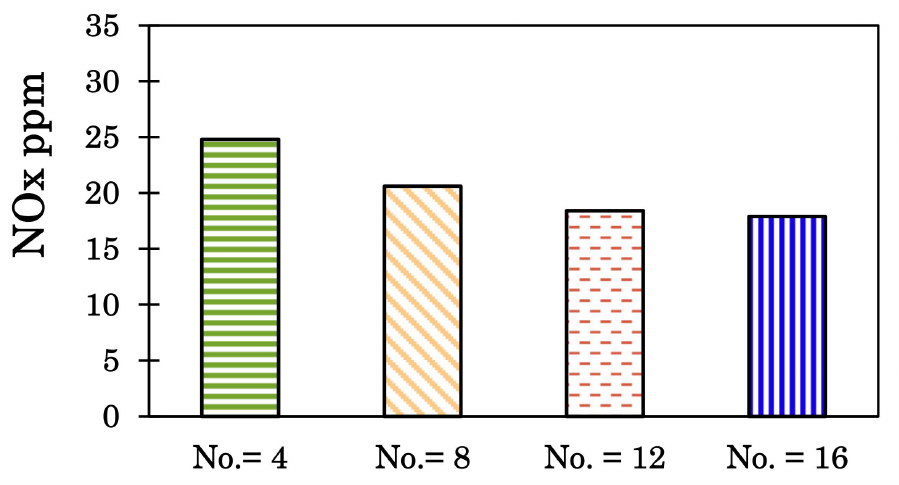
Figure 10. NOx comparisons for different nozzle orifice